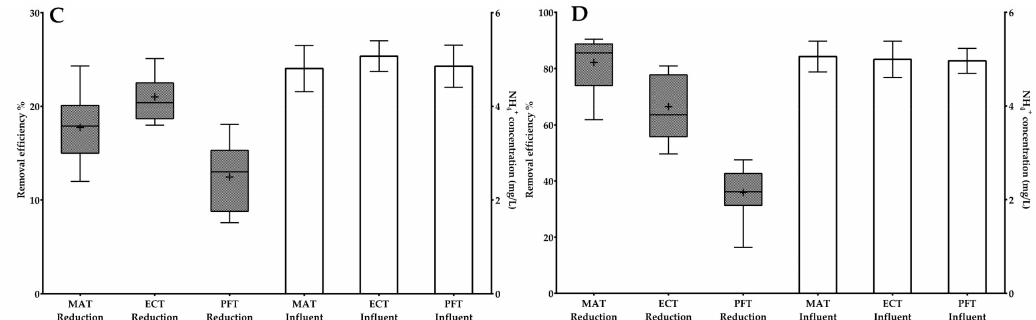
Figure 3. Removal efficiencies and influents of chemical oxygen demand (COD) and NH 4+ in the LSCW at different hydraulic retention times (HRTs). COD influents and removal efficiencies by different treatments are shown at HRTs of 4 d ( A ) and 7 d ( B ), whilst NH 4+ influents and removal efficiencies are shown at 4 d ( C ) and 7 d ( D ). MAT, ECT, and PFT represent LSCW treatment with M . aquaticum , E . crassipes , and polyethylene fiber, respectively. Black solid lines and plus signs represent the median and mean of the datasets, respectively. The bottom and top edges of the box plots indicate the 25th and 75th percentiles, and the whiskers illustrate the 2.5th and 97.5th percentiles. The bar plots stand for the means of influent pollutant concentrations, and error bars for the standard deviation (SD).